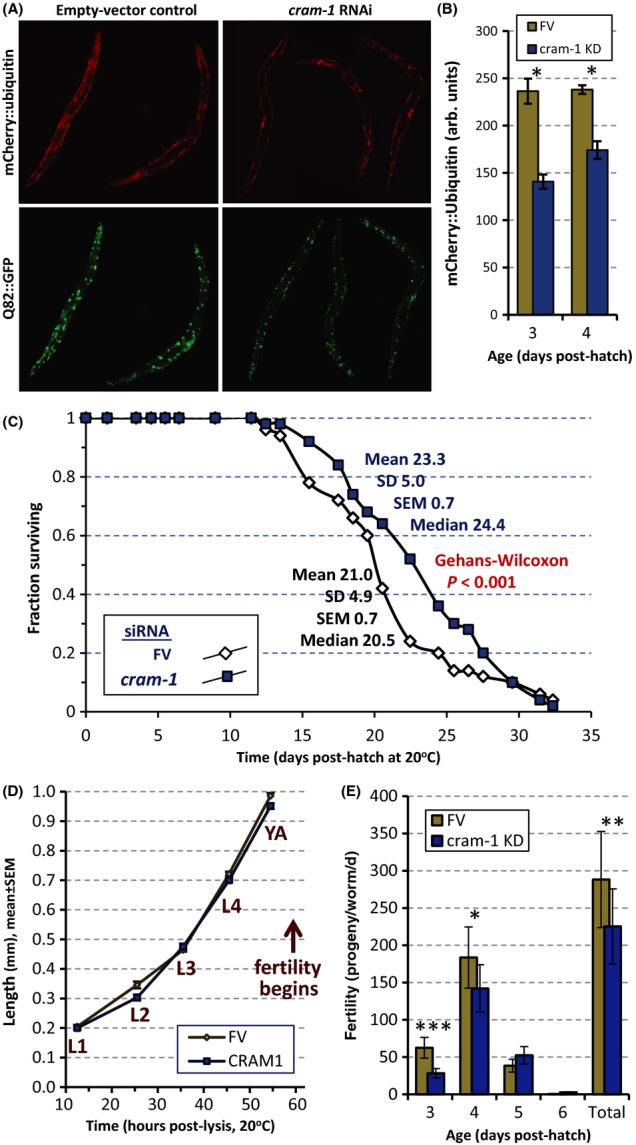
RNAi to cram-1 extends lifespan and lowers fecundity. (A) Images of worms expressing mCherry::ubiquitin (upper panels) and Q82::GFP (lower) in body wall muscle, at 3 dPH (adult day 1). Worms were fed FV bacteria (left panels), or cram-1 siRNA bacteria (right panels). (B) Red fluorescence (mCherry-ubiquitin) was quantitated by ImageJ (http://fiji.sc/Fiji), from images as in A, 10–12 worms per group, at 3–4 dPH (adult days 1–2). *Each two-tailed t-test P < 6E-6. The mean decline in fluorescence, at 3 dPH (two repeats), was 46%. (C) Lifespan data for wild-type Caenorhabditis elegans fed from the L4/adult molt on FV or cram-1-dsRNA bacteria. Worms were transferred to fresh plates daily for 8 day to remove progeny and scored at 1- or 2-day intervals for movement (spontaneous or after gentle prodding). In two independent experiments (35 worms/group), cram-1 RNAi extended mean lifespan 11–12% (each P < 0.001, Gehans–Wilcoxon test). (D) Worm dimensions were measured at the indicated stages (larval, L1–L4; young adult, YA) and times (x-axis, hours after egg isolation), using WormSizer, a Fiji plug-in (http://fiji.sc/Fiji). Lengths (shown) and widths (not shown) did not differ significantly at any time, between worms receiving cram-1 dsRNA or FV control bacteria, in three experiments. Error bars, often smaller than symbols, show ± SEM. (E) Fertility data for worms maintained as in (D). Parents were moved to fresh plates at 24-h intervals; L2 larvae were counted 24 h later for 10–14 plates per group. Similar results were obtained in replicate experiments. Significance by two-tailed t-tests, cram-1 KD vs. FV control: *P < 2E-3; **P < 4E-4; ***P < 2E-5.